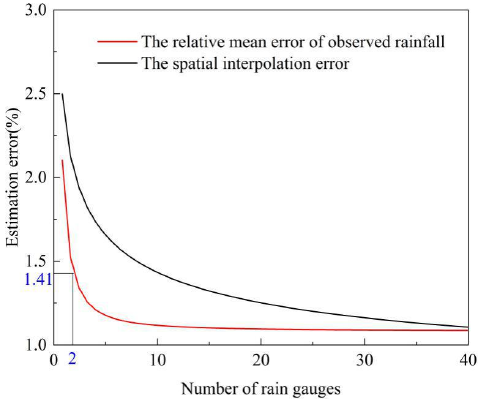
Figure 5. Scatter plots of the MC and MD between rain gauges.